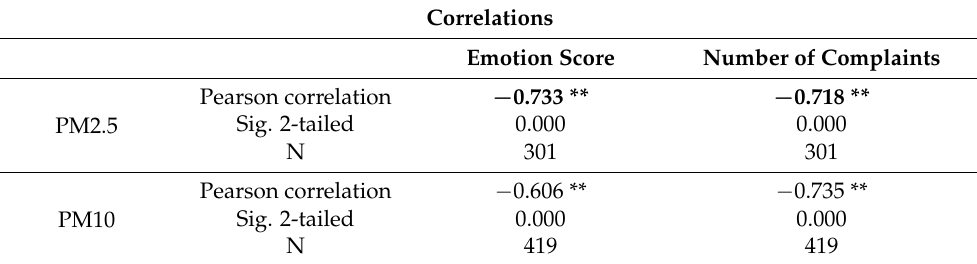
Table 3. Correlation analysis of PM2.5 and PM10 with the number of public complaints and emo- tional intensity. Correlations Emotion Score Number of Complaints Pearson correlation − 0.733 ** − 0.718 ** Sig. 2-tailed 0.000 0.000 PM2.5 N 301 301 Pearson correlation − 0.606 ** − 0.735 ** Sig. 2-tailed 0.000 0.000 PM10 N 419